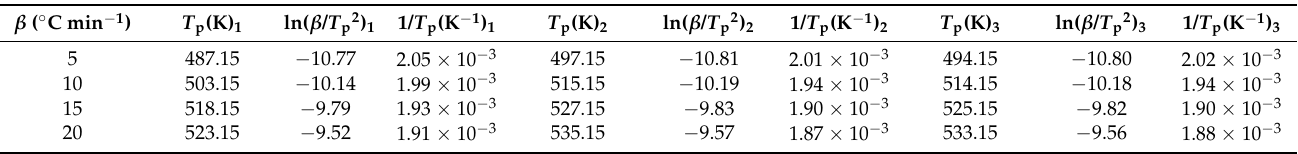
Figure 12. DSC curves and parameters of the monomer curing agent mixture. Table 2. The values of ln( β / T p2 ) and 1/ T p .